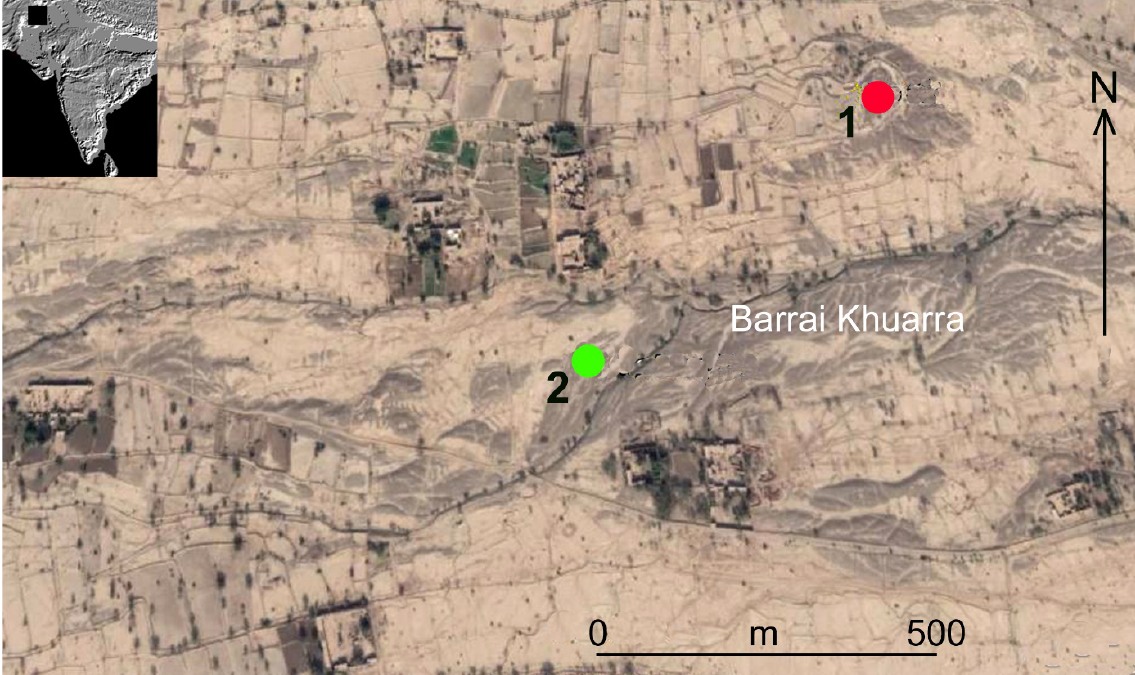
Figure 1. Locations of the Levallois tool on the gravel terraces of Barrai Khuarra (n. 2) and the Neolithic site of Sheri Khan Tarakai (n. 1) (drawing by P. Biagi,